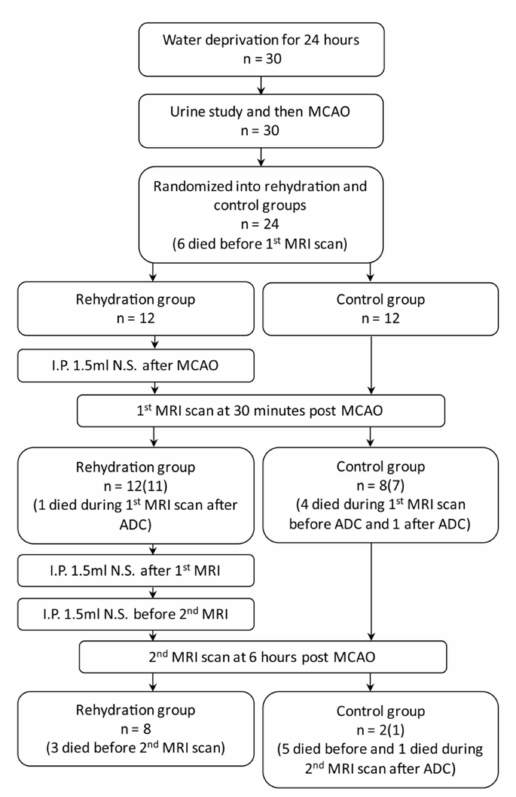
Figure 1. A flowchart of study workflow. (Case numbers in the parenthesis represent the number of rats completed the MRI scan with perfusion imaging). MCAO, middle cerebral artery occlusion; ADC, apparent diffusion